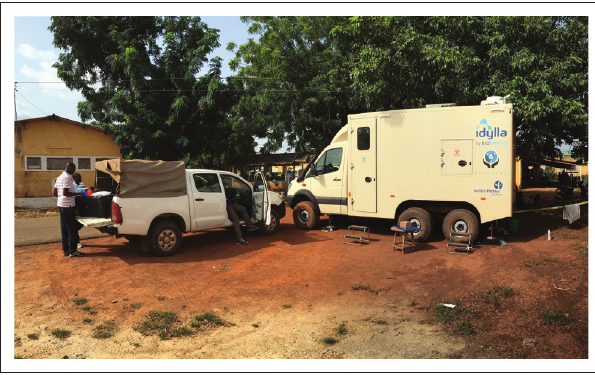
Source : Photo taken by Steven Pauwels, Praesens Foundation. FIGURE 3: Deployment and implementation of the mobile biosafety laboratory in the field, Kédougou, Senegal, October 2017.